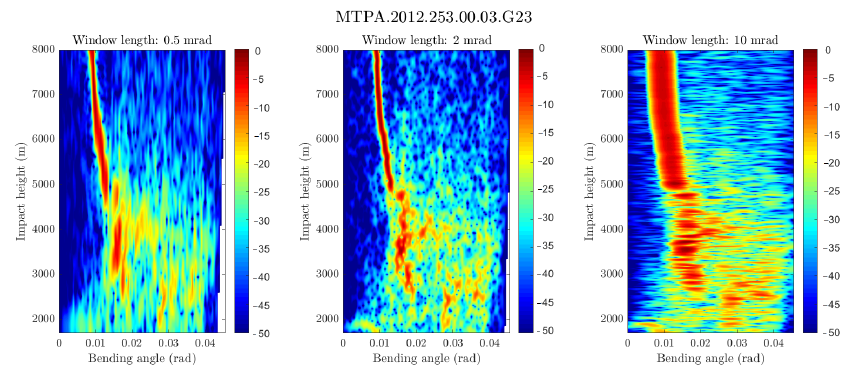
Figure 7. Occultation event from UTC 0003 2012-09-11, 20.16 ◦ S, 114.93 ◦ E. An illustration of the effects of different window lengths. With shorter windows, uncertainty in IH grows (left). Longer windows cause more uncertainty in BA